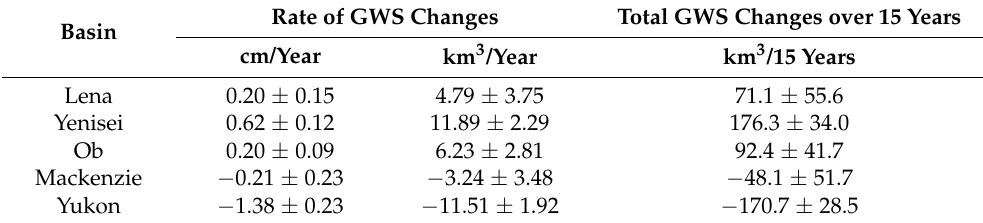
Table 1. Rate of GWS changes and total GWS changes over 2002–2017 in the five pan-Arctic river basins